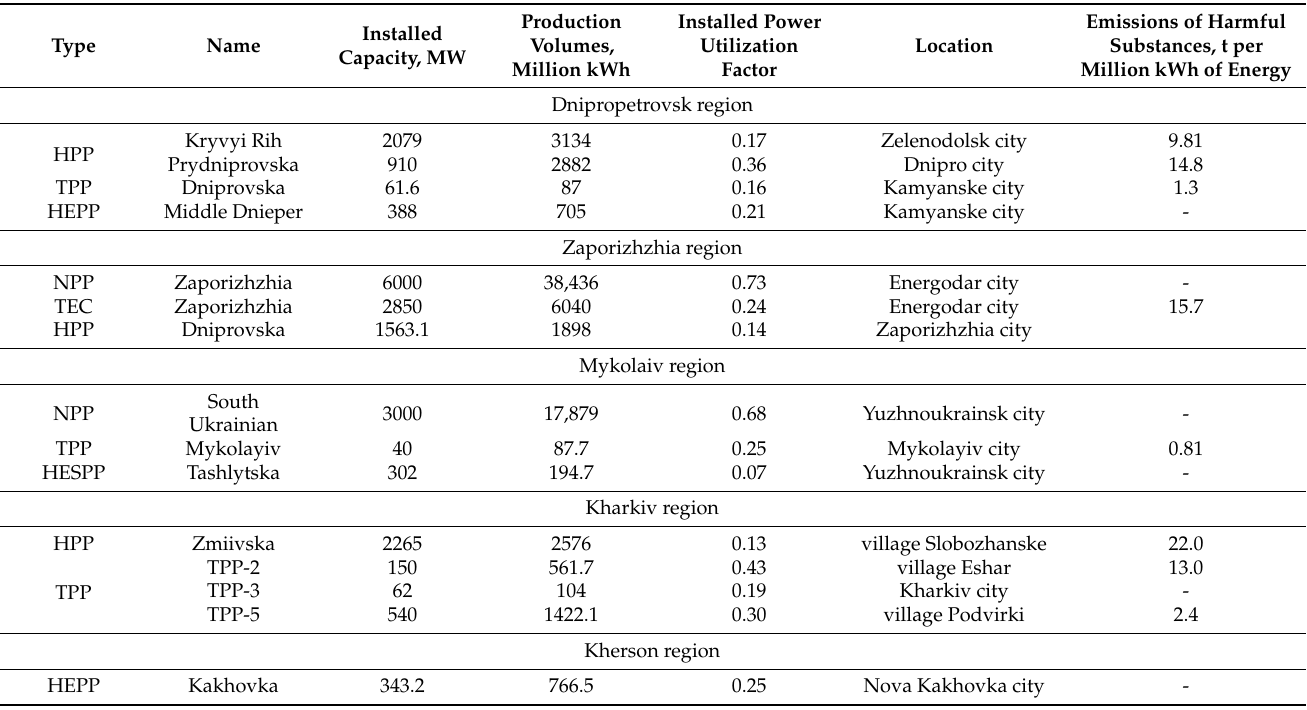
Table 1. Technical and economic indicators of the leading industrial producers of electricity in the south-eastern region of Ukraine in